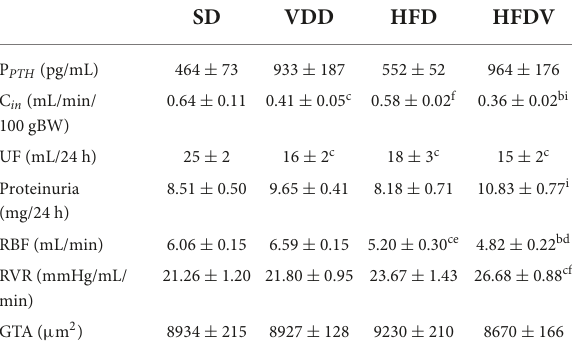
TABLE 2 Renal function, biochemical parameters, and glomerular tuft area evaluated after the 90-day protocol in rats submitted to renal ischemia-reperfusion insult on day 45 treated with standard diet (SD), vitamin D-free diet (VDD), high-fat diet (HFD), or high-fat vitamin D-free diet